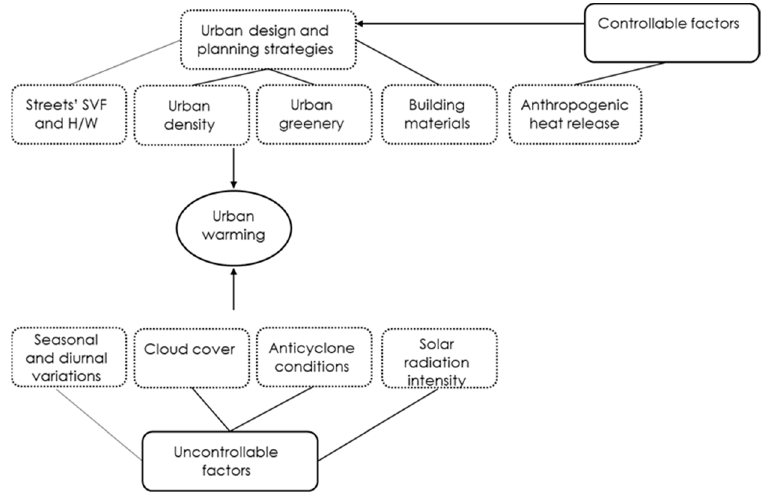
Figure 1. Parameters affecting the urban microclimate and contributing to the generation of the urban heat island (UHI) phenomenon.